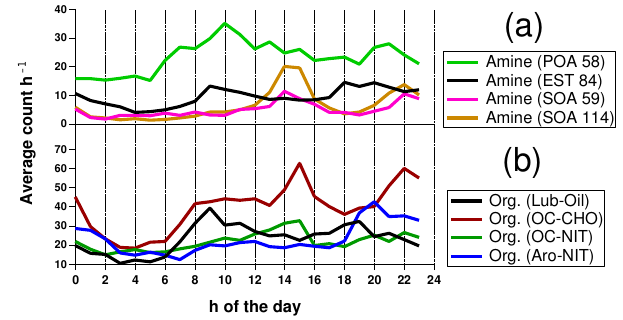
Figure 6. Diurnal trend of amines (a) and organic-rich (b) particle types detected at the RS site. Differences between RS and UB sites were minor and average diurnal profiles are